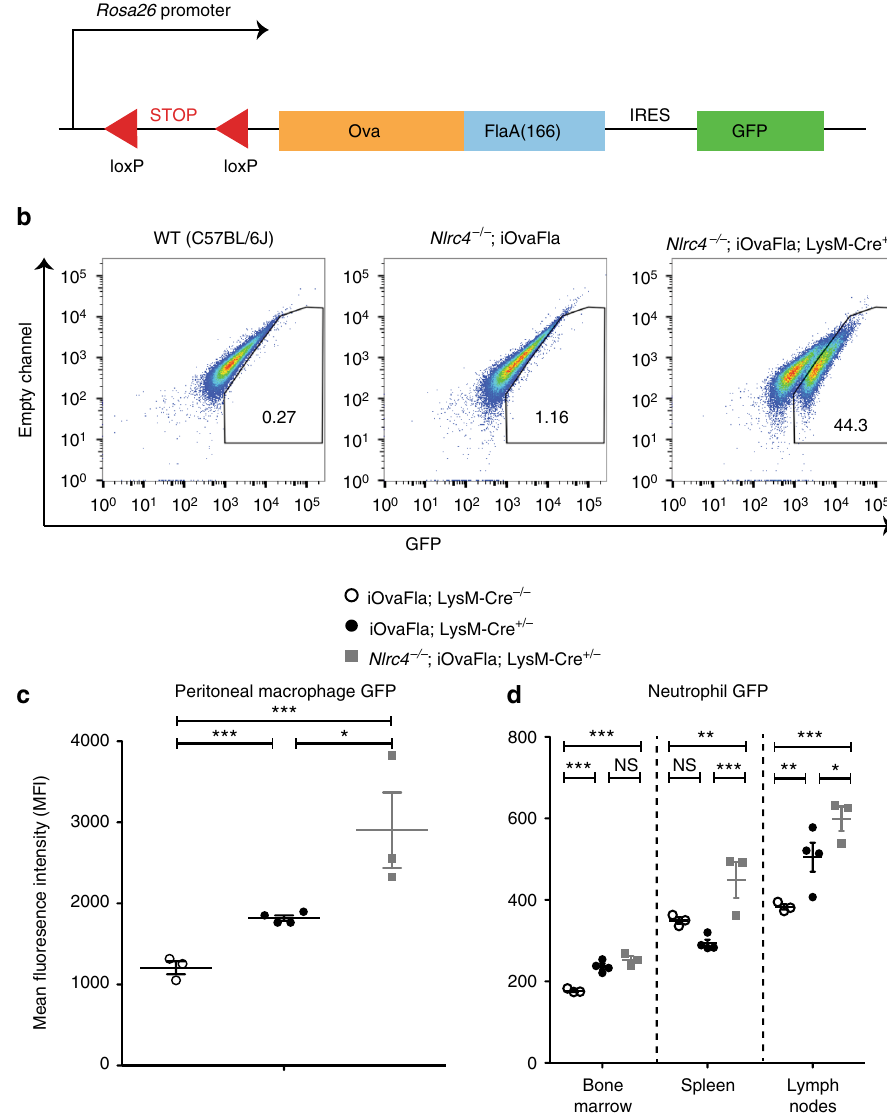
Fig. 1 Genetic system for inducible NLRC4 in fl ammasome activation in vivo. a Schematic showing iOvaFla transgene insertion in the Rosa26 locus. b Flow cytometry analysis of bone marrow derived macrophages (BMMs) cultured from WT, Nlrc4 − / − ; iOvaFla and Nlrc4 − / − ; iOvaFla; LysM-Cre +/ − mice (representative images from three biological replicates), c peritoneal macrophages (CD11b + F4/80 + ) from iOvaFla; LysM-Cre − / − , iOvaFla; LysM-Cre +/ − , and Nlrc4 − / − ; iOvaFla; LysM-Cre +/ − mice, and d neutrophils (CD11b + Ly6G Hi , Ly6C Lo ) from the bone marrow, spleens and lymph nodes. Data in b – d are representative of two independent experiments. Error bars are s.d. Results were analysed with a two-way ANOVA and Bonferroni post-tests; * p < 0.05, ** p < 0.01, *** p <